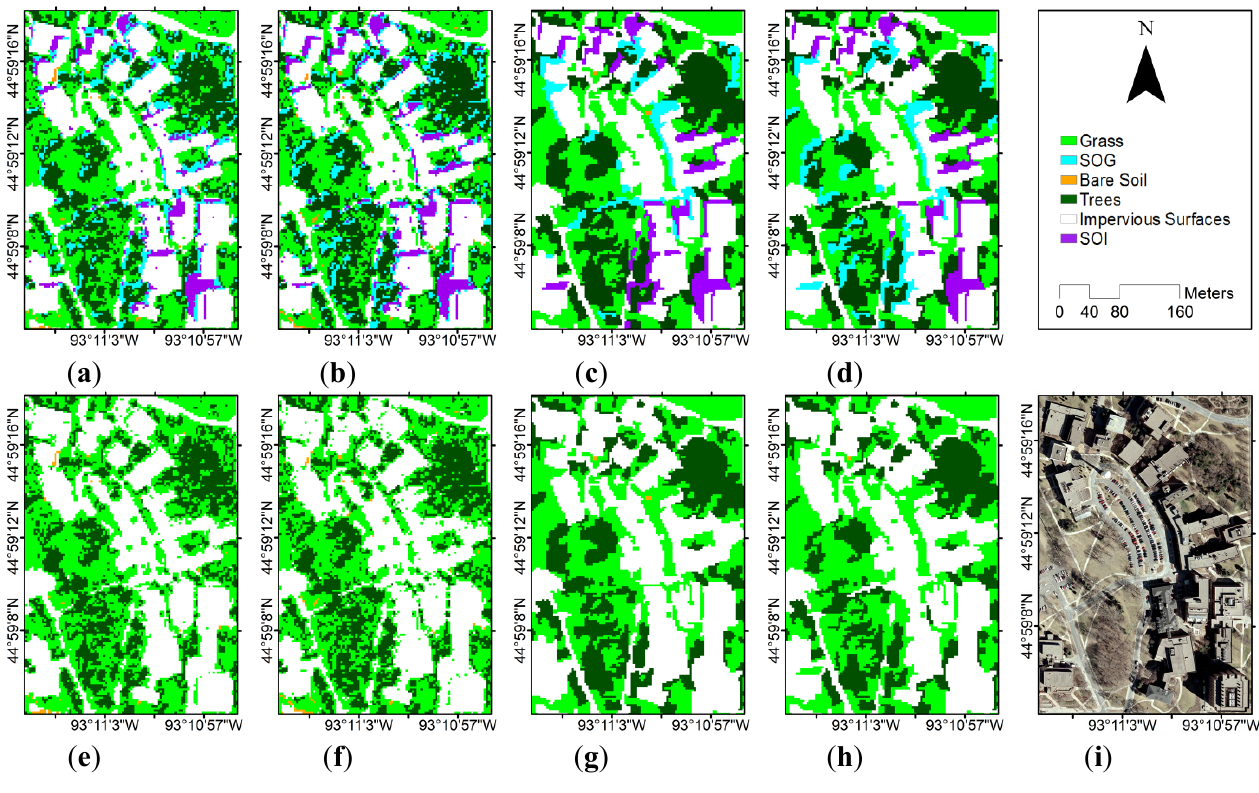
Figure 4. Shadow areas detected and classified in the land use and land cover map of a portion of the University of Minnesota Saint Paul Campus with two pixel-based (panels ( a ) and ( b ), without and with shadow thresholding, respectively.) and two object-oriented methods (panels ( c ) and ( d ), without and with shadow thresholding, respectively). Shadow on grass (SOG) and shadows on impervious surfaces (SOI) were reclassified to grass and impervious surfaces, respectively, in panels ( e – h ) corresponding to panels (a–d), respectively. Panel ( i ) shows the color aerial imagery (acquired on 8 April 2003) of the same